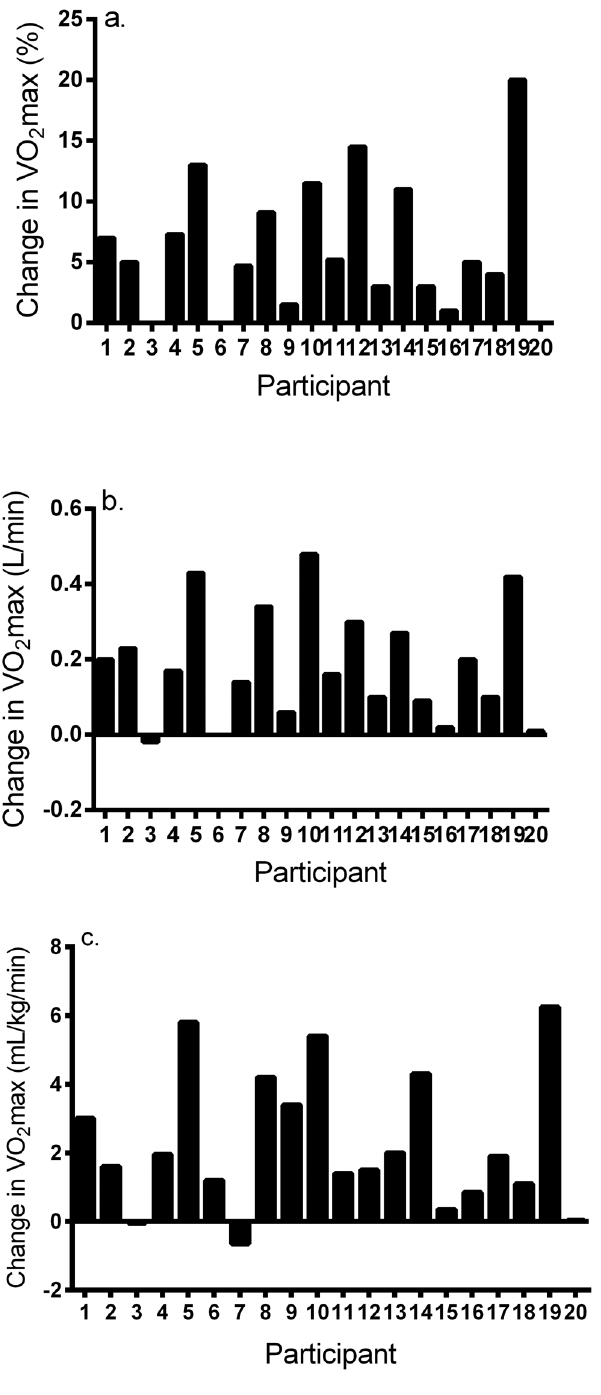
Figure 1. Individual responses for a) percent change in VO 2 max; b) absolute change in VO 2 max; and c) relative change in VO 2 max in response to 2 wk of low-volume interval